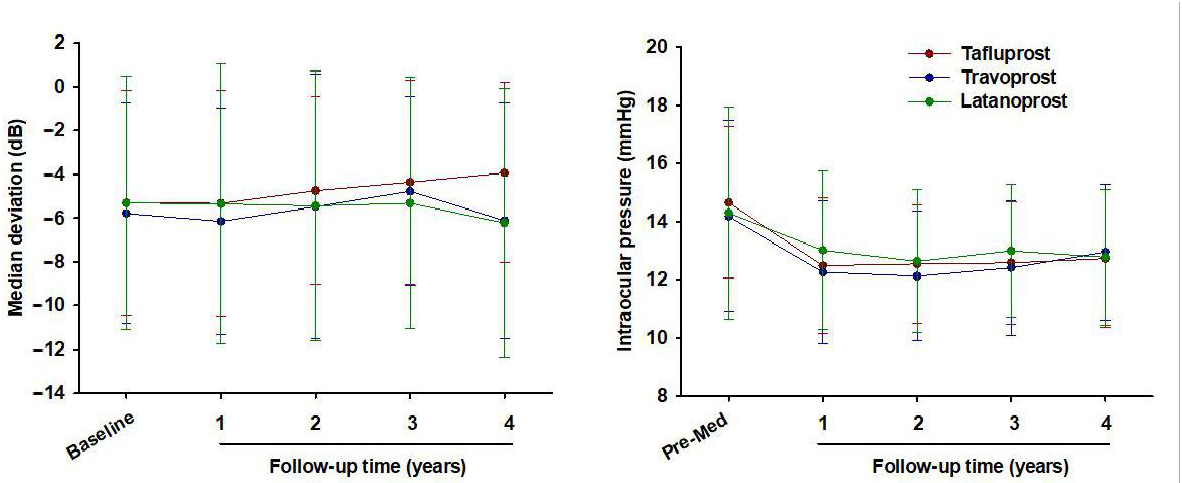
Figure 4. Median deviation ( left ) and intraocular pressure ( right ) – time curves in patients diagnosed with NTG, who received long-term treatment with three PGAs (tafluprost ( n = 58), travoprost ( n = 58) or latanoprost ( n = 58)) and completed the study (Match Set 2).